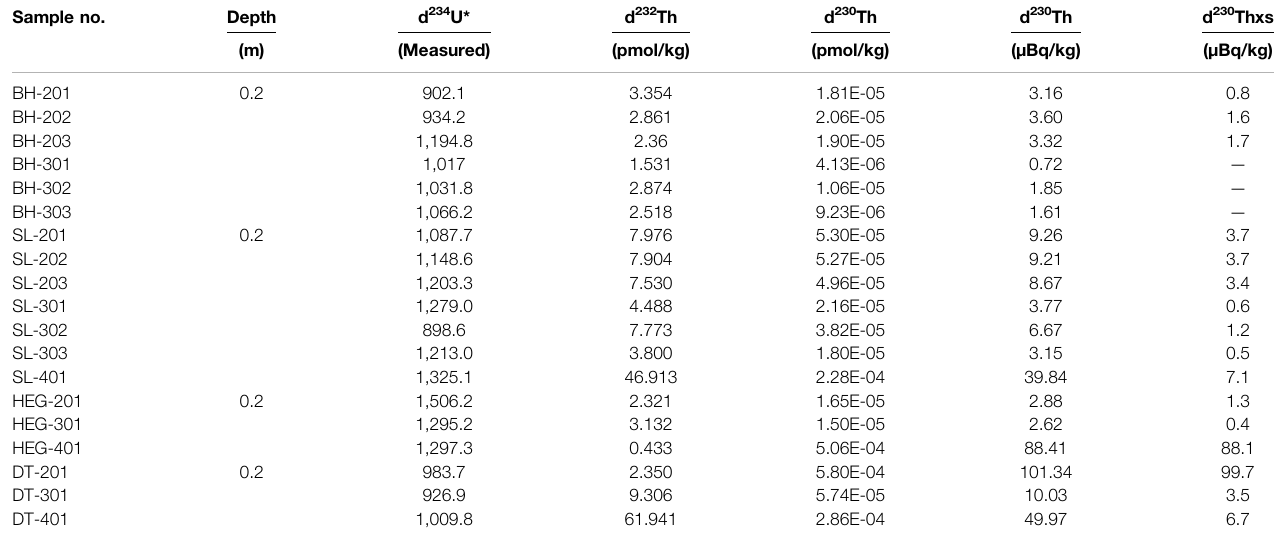
TABLE 3 | Distribution of Th isotope concentrations in exogenous recharge river water. Sample